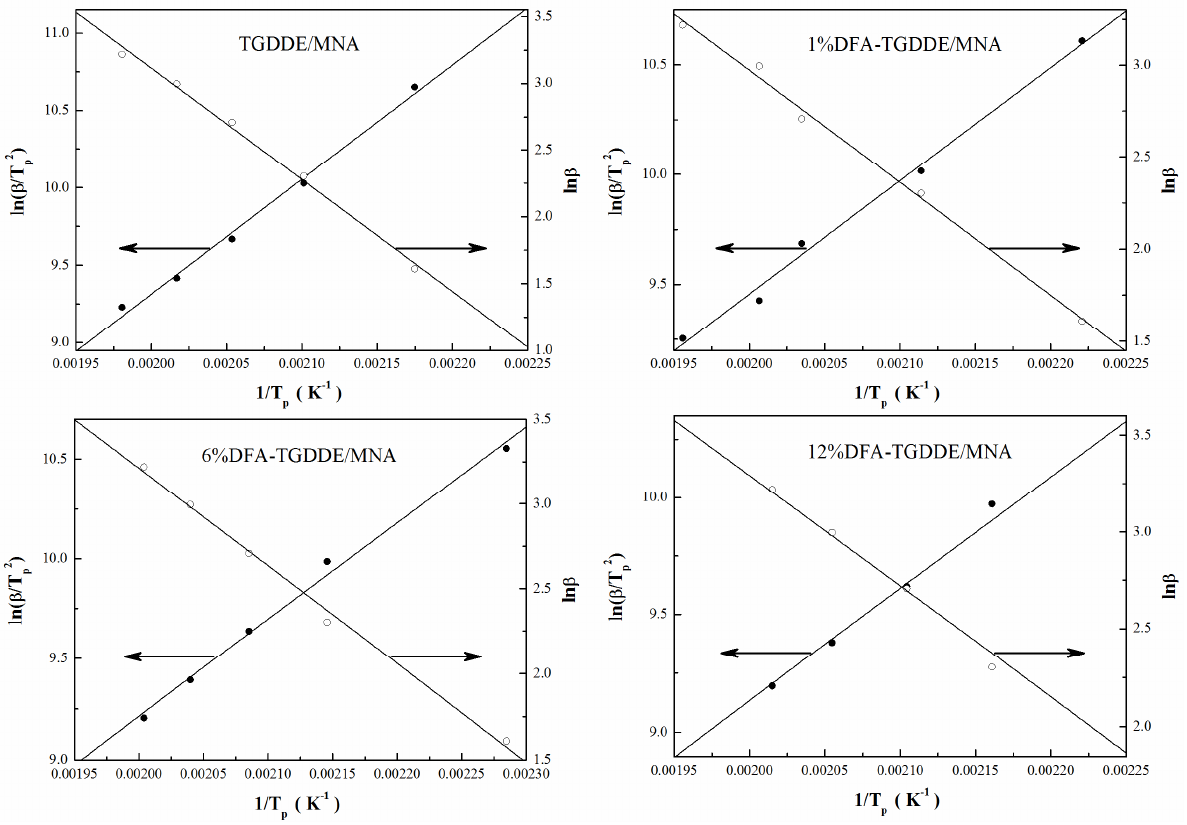
Figure 6. ln( β /T 2 p ) and ln β vs. 1/ T p of the curing systems.